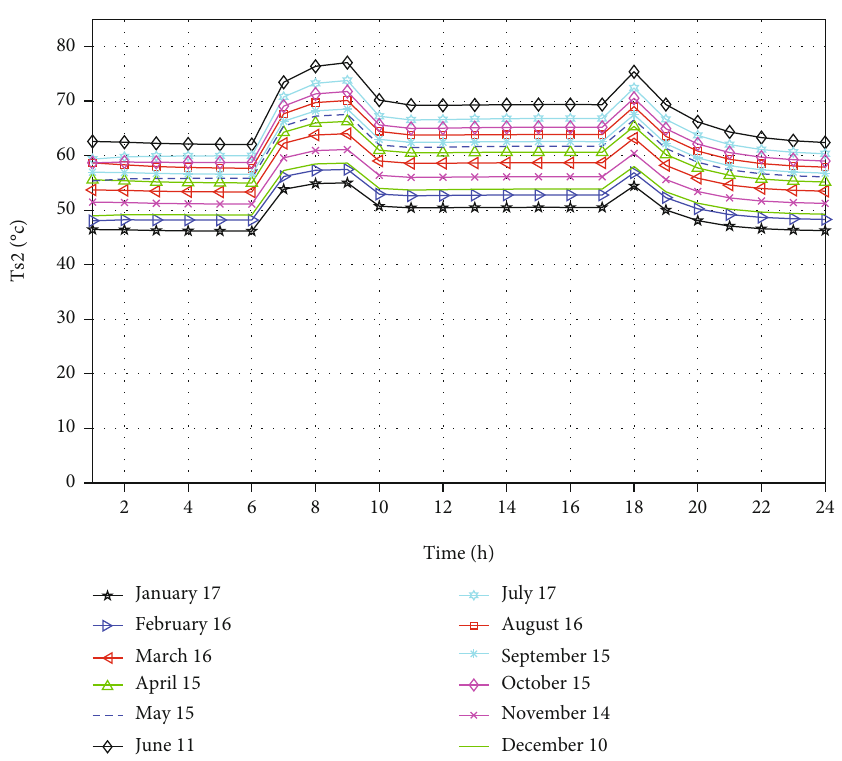
Figure 12: Water temperature with 75% electrical energy supply during 12 hours of the day and 25% during the